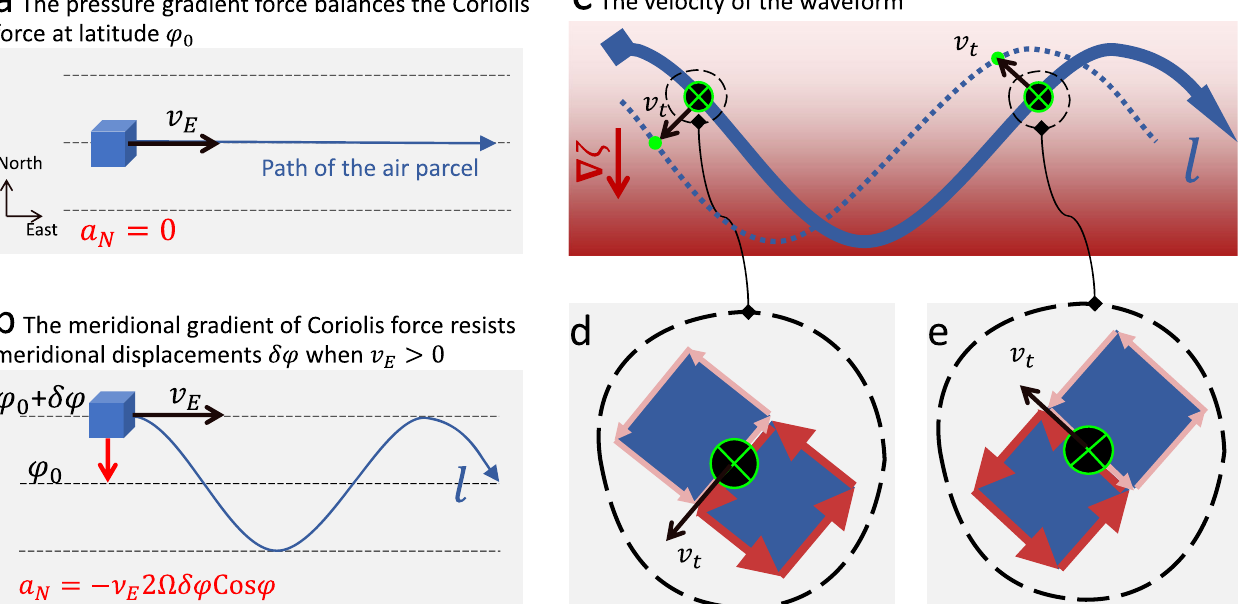
Fig. 1 | Sketches of Rossby waves ’ fundamental principles. a , b The restoring force. c – e Thewaveform ’ svelocity.In( a ),anairparcelfollowsalonglatitude φ 0 atan eastward velocity v E with a meridional acceleration a N =0 when the pressure gra- dient force balances the Coriolis force. In b , when the parcel encounters a small displacement δφ in latitude, the Coriolis force ’ s gradient imposes a meridional acceleration a N = δφ d a C = d φ = (cid:1) δφ v E 2 Ω Cos φ 0 thatalwayspointsagainst δφ when v E >0. Here, Ω denotes the Earth ’ s angular frequency and a C = (cid:1) ν E 2 Ω Sin φ is the northward Coriolis acceleration. While the parcel meanders along the blue arrowed line l in ( b ), its waveform travels westward as sketched in c . The absolute vorticity composes the planetary vorticity f =2 Ω Sin φ and the relative vorticity ζ , re fl ecting